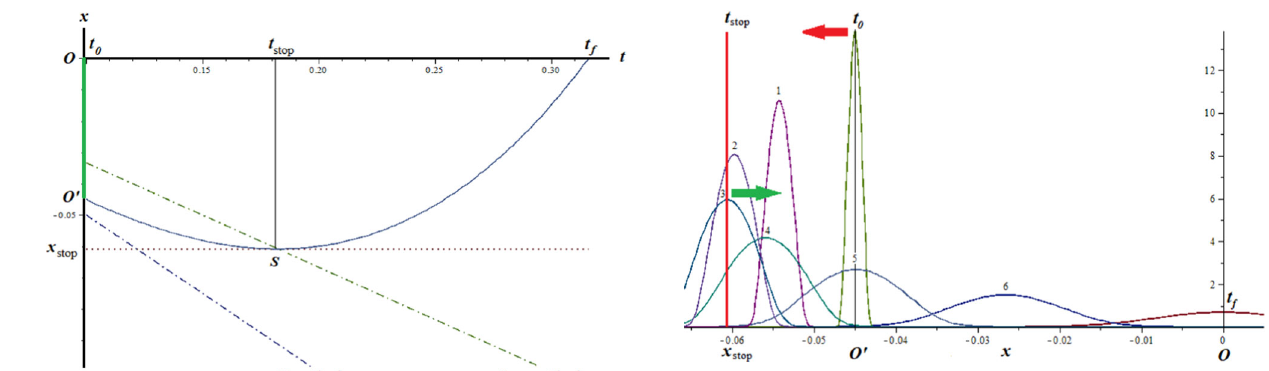
Fig. 4 Profile of the null geodesic x m ( t ) of the maximum intensity of the wave packet with γ = 0 . 001 and ¯ k = 10000 in the space-time with s = 3, r a ( t 0 ) = 0 . 0333 and r e ( t 0 ) = 0 . 05. The packet is prepared in O (cid:4) at the time t 0 = 0 . 1 and r a ( t 0 ) < d = 0 . 045 < r e ( t 0 ) and measured in O at the time t f = 0 . 3162. The maximum intensity stops in x stop = − 0 . 0608 at the time t stop = 0 . 1825